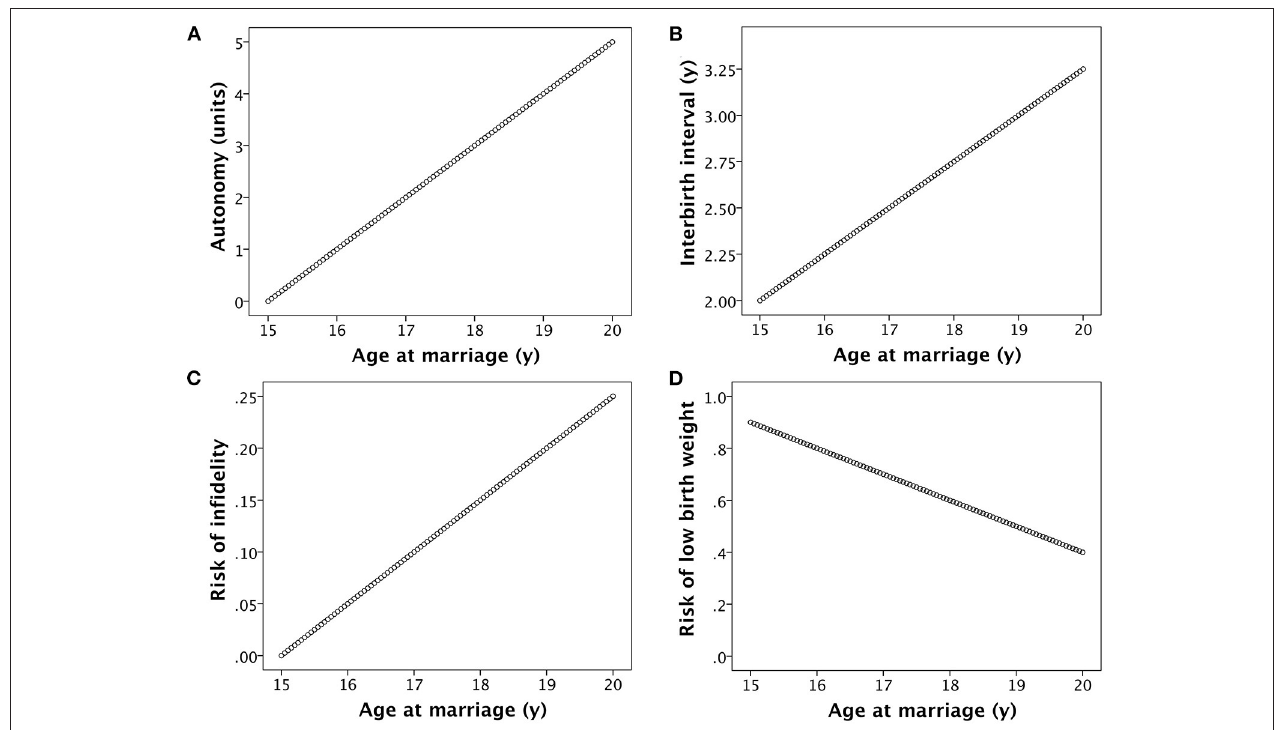
FIGURE 3 | Basic assumptions in the model. (A) Women’s autonomy increases in association with age at marriage, due to a combination of greater formal education and greater informal investment in skills and competencies by members of the natal household. (B) The inter-birth interval increases in association with women’s age at marriage, due to greater autonomy providing increased control over contraception and fertility. (C) The risk of women’s infidelity increases in association with their age at marriage, mediated by the development of a large social network and greater autonomy. (D) The risk of low birth weight declines with increasing women’s age at marriage, mediated by factors such as greater autonomy over decisions related to child care and longer inter-birth